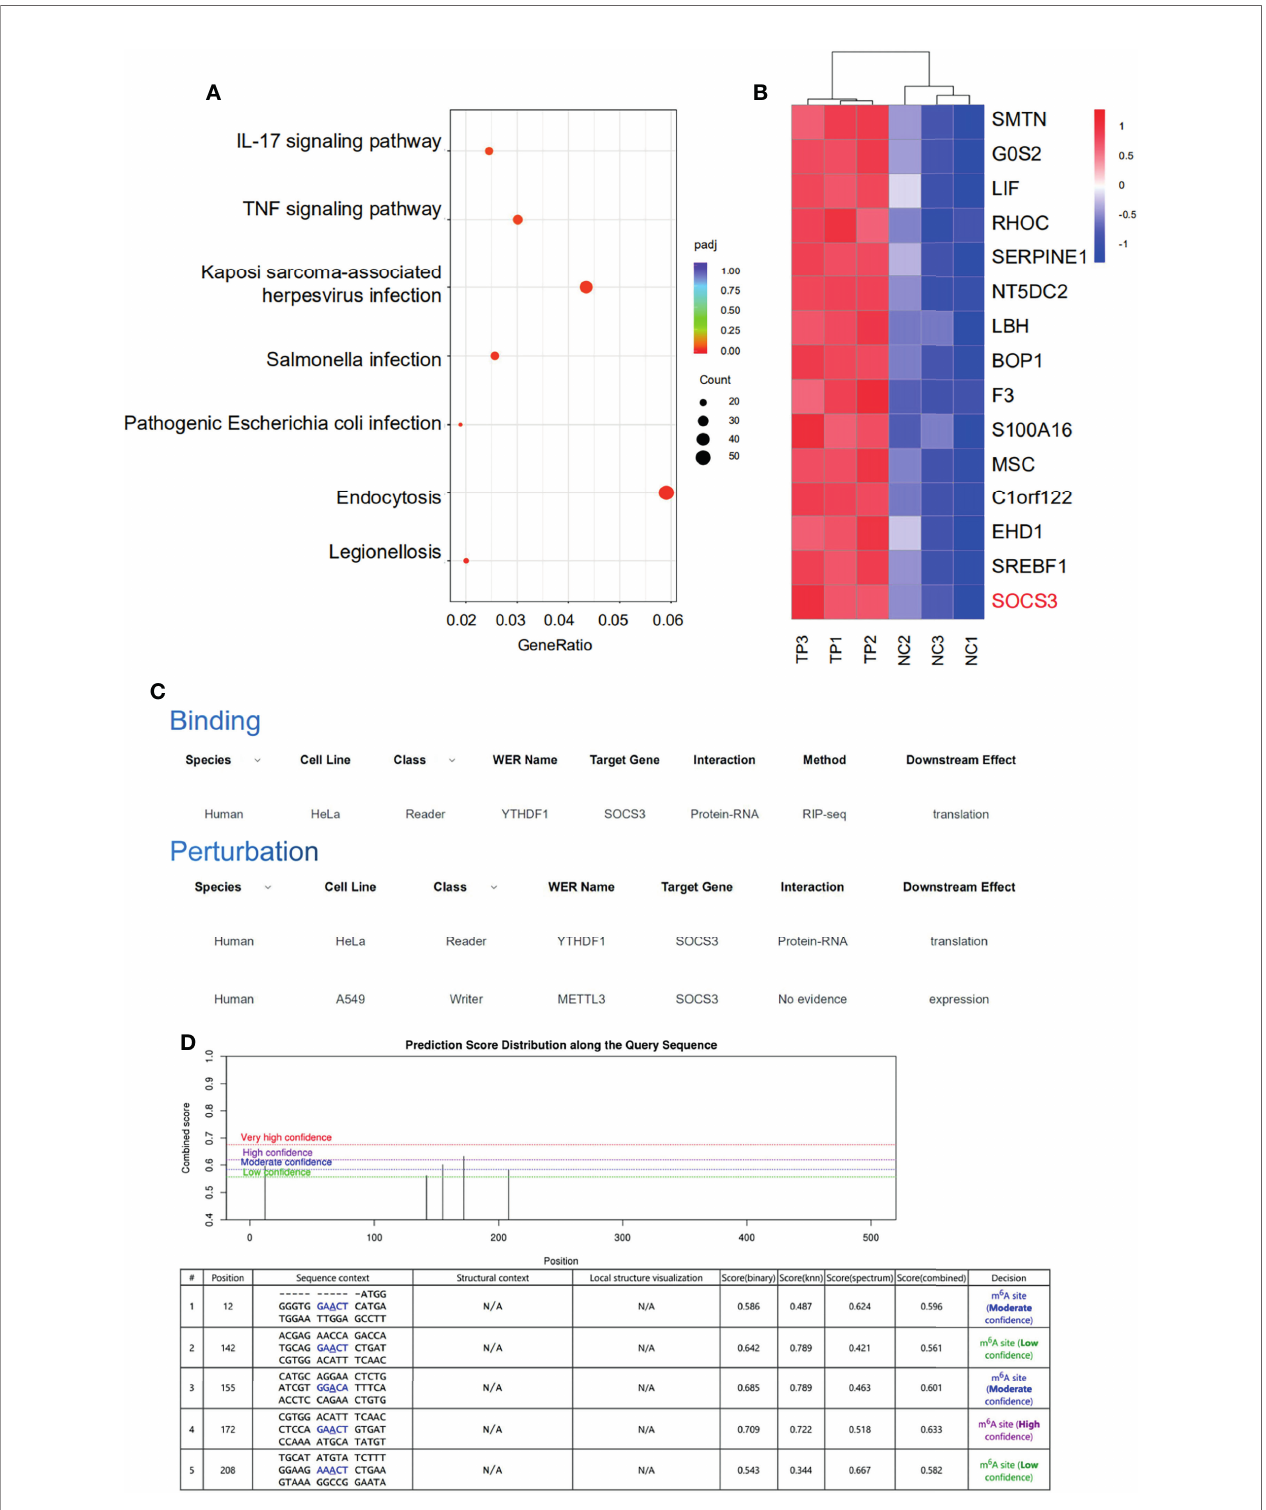
FIGURE 3 | SOCS3 may be the target of the m6A reader YTHDF1 in TP-infected macrophages. (A) KEGG pathway analysis of biological processes associated with in fl ammation and infection in the RNA-seq dataset. (B) Heat map of the top 15 signi fi cantly upregulated mRNAs in TP-infected macrophages compared with control cells. (C) The association of binding and perturbation between YTHDF1 and SOCS3 was predicted by m6A2Target. (D) The potential m6A sites on SOCS3 mRNA were analyzed by